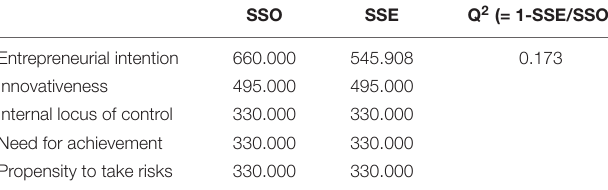
TABLE 7 | Construct cross-validated redundancy.